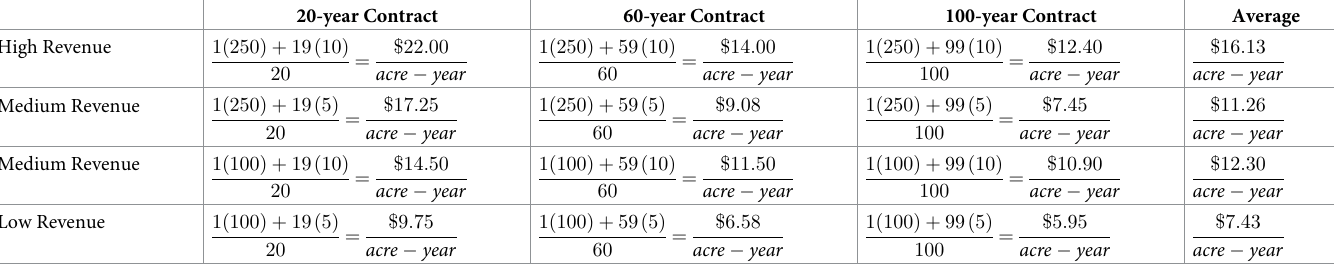
Table 2. Selection of potential average, per acre, per year revenue generation